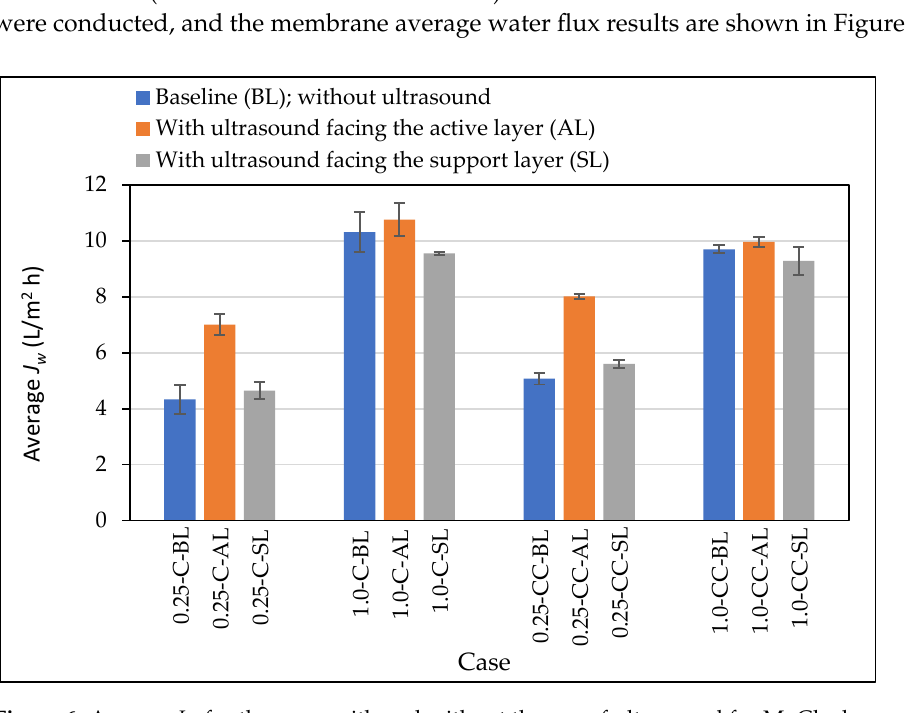
Figure 6. Average J w for the cases with and without the use of ultrasound for MgCl 2 draw solution. The error bar represents the lower and upper average J w associated with the two runs of the tested case.